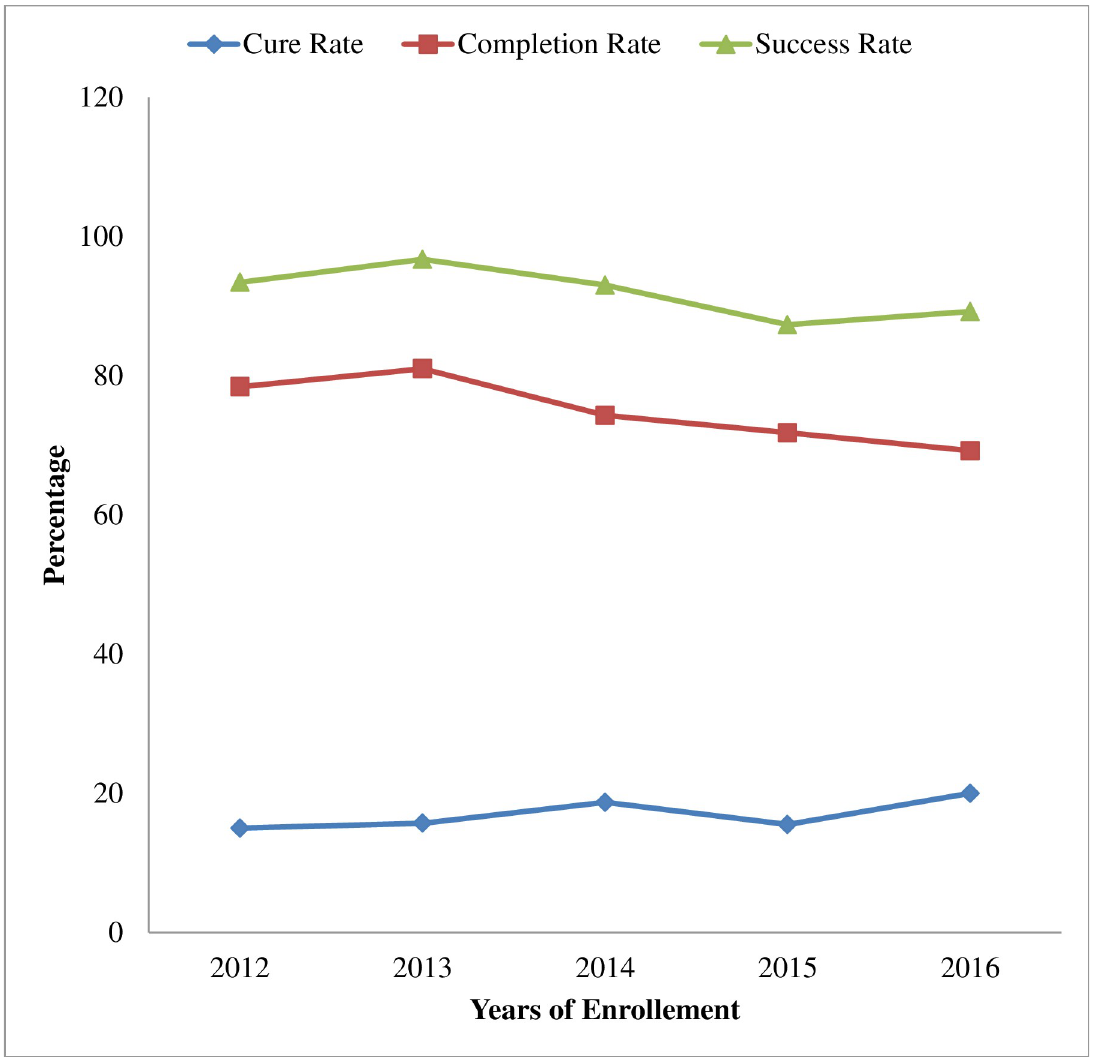
Fig 5. Trends of treatment success rates of TB patients at three TB treatment centers in East Wollega from 2012 to 2016.